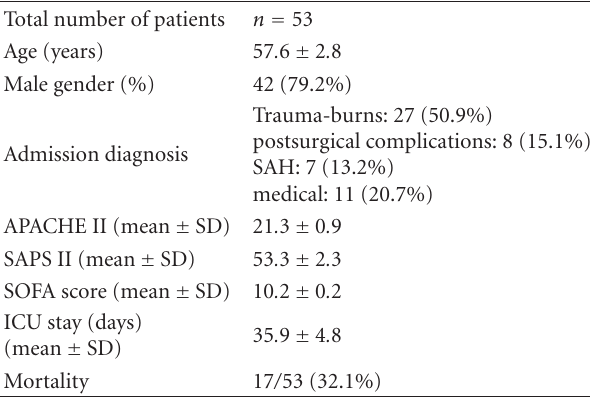
Table 1: Clinical characteristics of the study